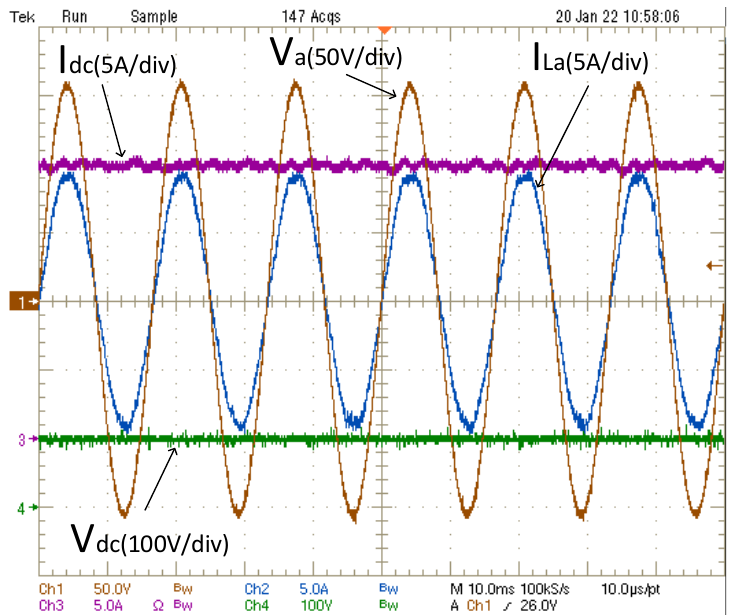
Figure 18. Experimental results in a steady state when the voltage at the terminals of each cell (50 cells in series) is set to 2 V. Test I (Table 2) with parameters in Tables 1 and